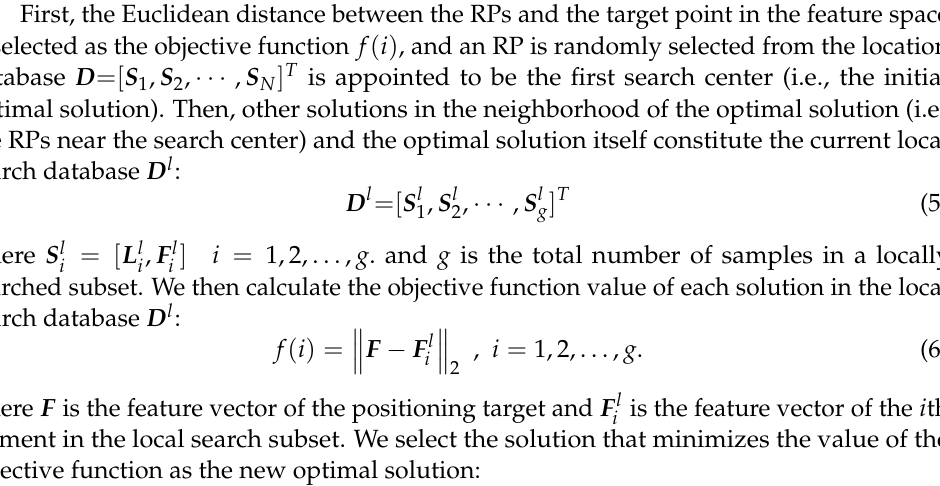
Figure 3. The RPs matching process based on a greedy